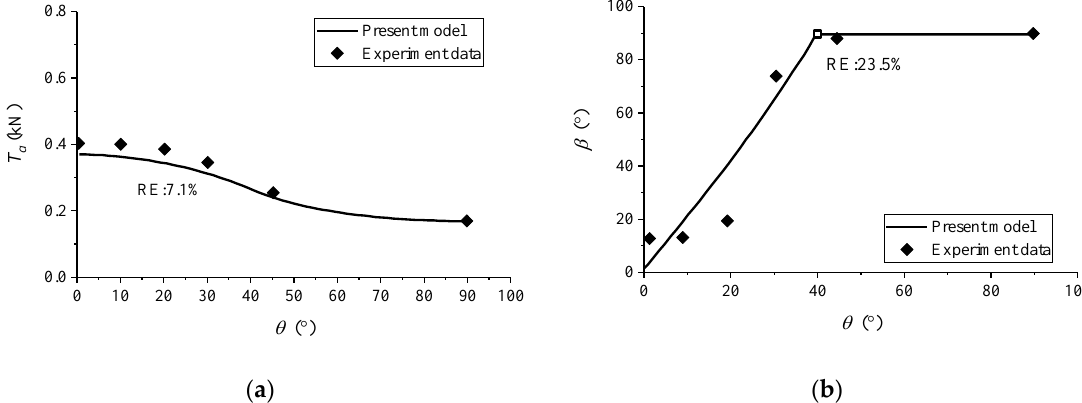
Figure 8. Comparative results of model tests conducted by EI-Sherbiny [35,44]: ( a ) Pullout capacity; ( b ) Failure angle.